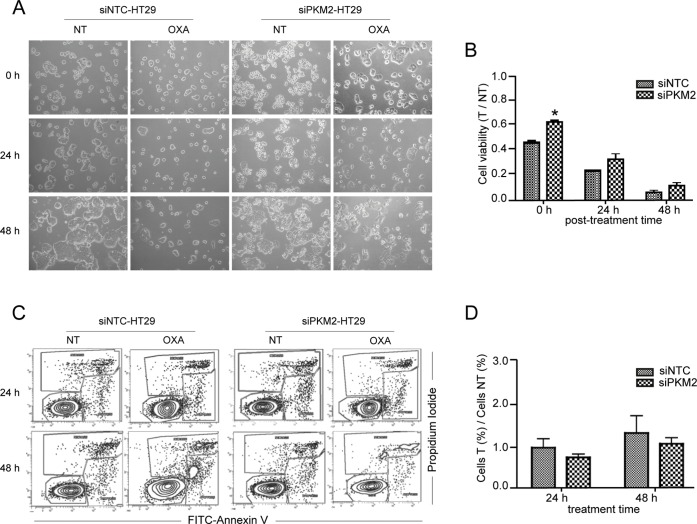
PKM2 silencing alters OXA response in HT29 cells but not apoptosis activation.After siRNA transfection cells were treated with 15 μM OXA for 24 h period, observed by optical microscopy at 0, 24 and 48 h after the end of drug exposure (0 h refers to cells treated for 24h; 24 h refers to cells treated for 24 h and left to recover for additional 24 h) (A) and quantified by trypan blue staining (B). Apoptosis activation after 24 and 48 hours of 10 μM OXA exposure was determined by FITC-Annexin V/ PI double staining (C) and measured as a ratio between percentages of apoptotic treated (T) and non-treated (NT) cells (D). Vertical bars in the graphics represent ± SD. *P-value < 0.05. NT: non-treated cells. Optical microscopy: objective 10x magnification.